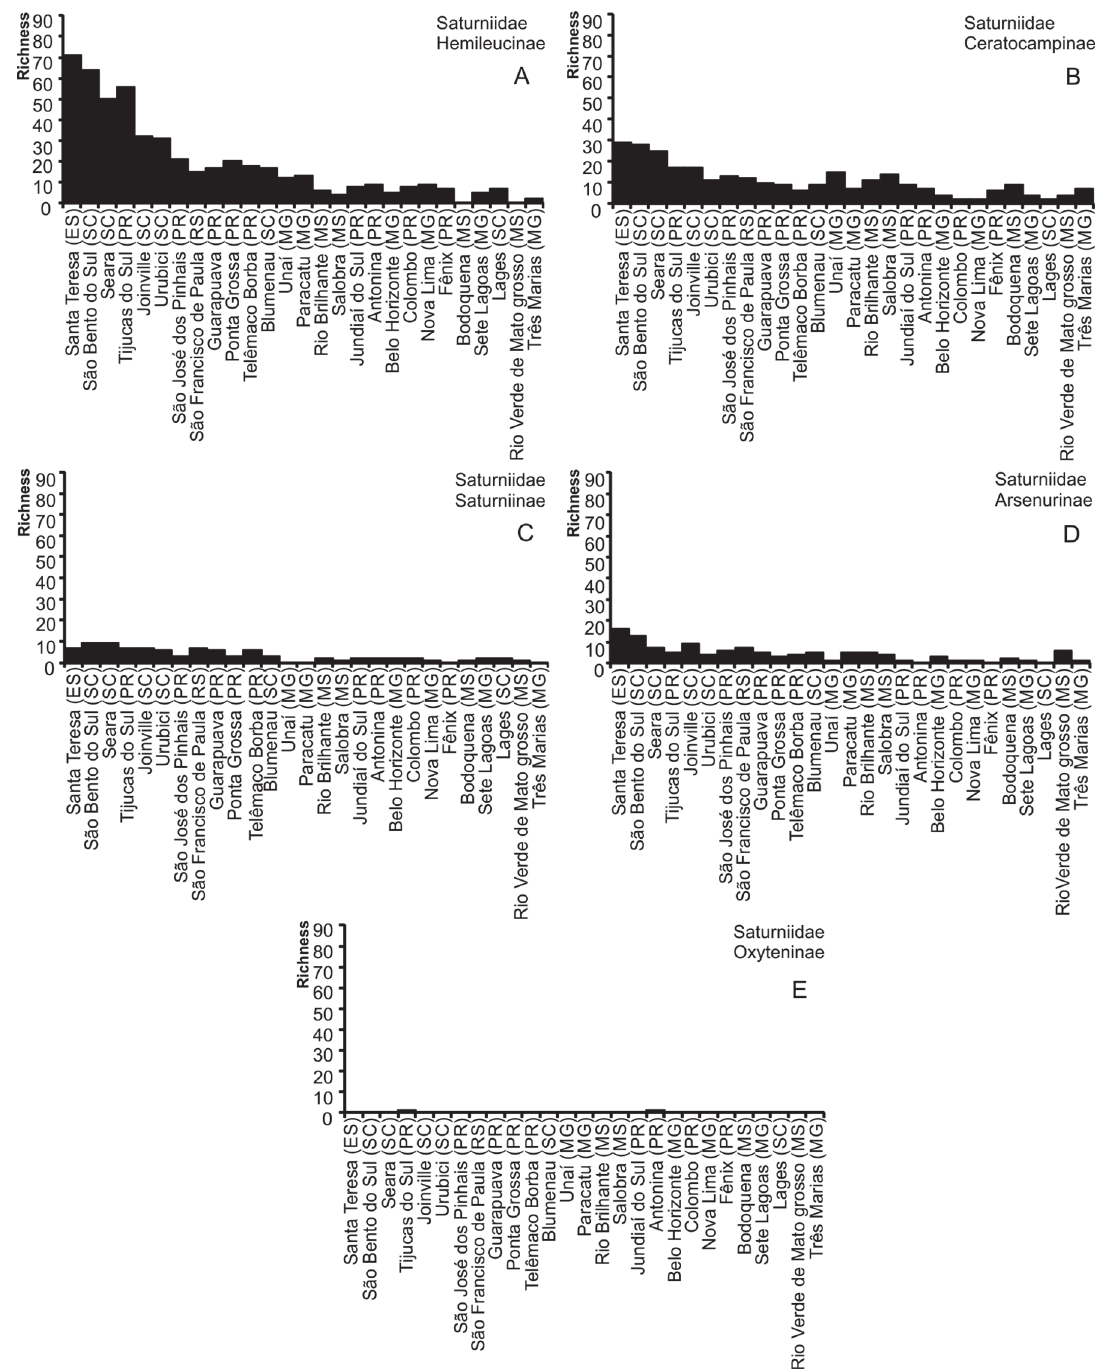
Figure 5 - Richness of the subfamilies of Saturniidae (A-E) compared between different